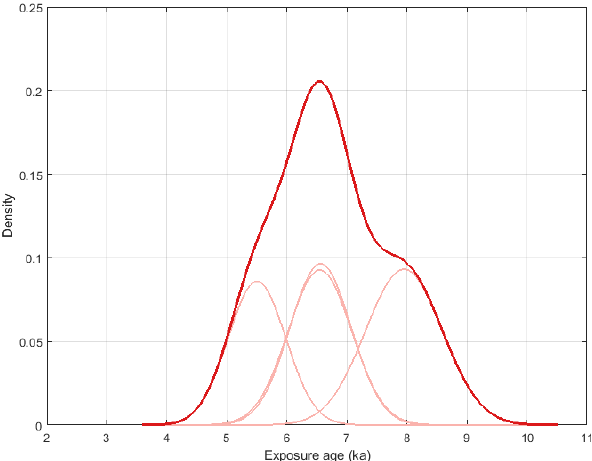
Figure A2. Kernel density estimate plot of in situ 14 C age distribution for lower Kay Peak ridge ( n = 4) with the two youngest ages (KAY 105, KAY 109) removed. Error weighted mean: 6472; standard error: 266; external error: 205; reduced chi squared: 3.29; chi-squared p value: